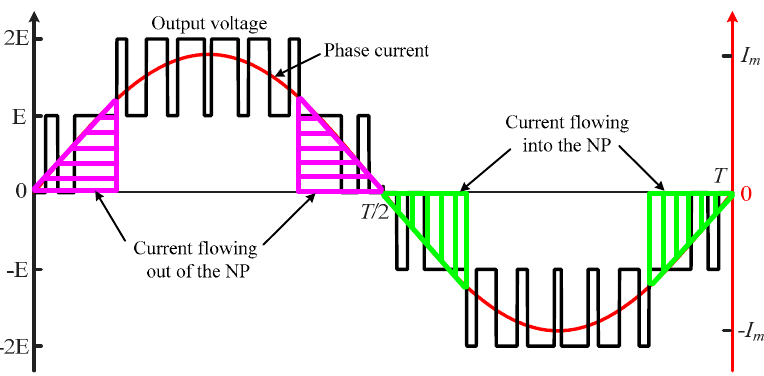
Figure 24. Voltage balancing principle of dc ‐ side NP for 5L converter under the unity power factor.